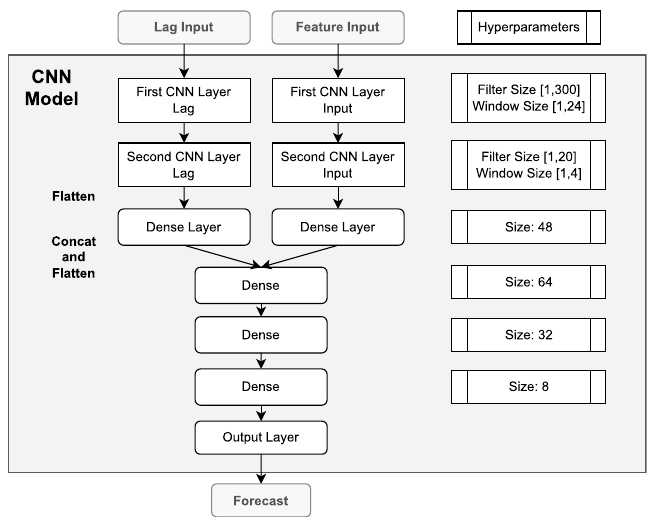
Fig. 4 The architecture of the complex CNN model used for net load forecasting. The model takes two inputs, lagged features and non-lagged features for the upcoming 24 h. The hyperparameter space used for hyperparameter optimisation is shown on the